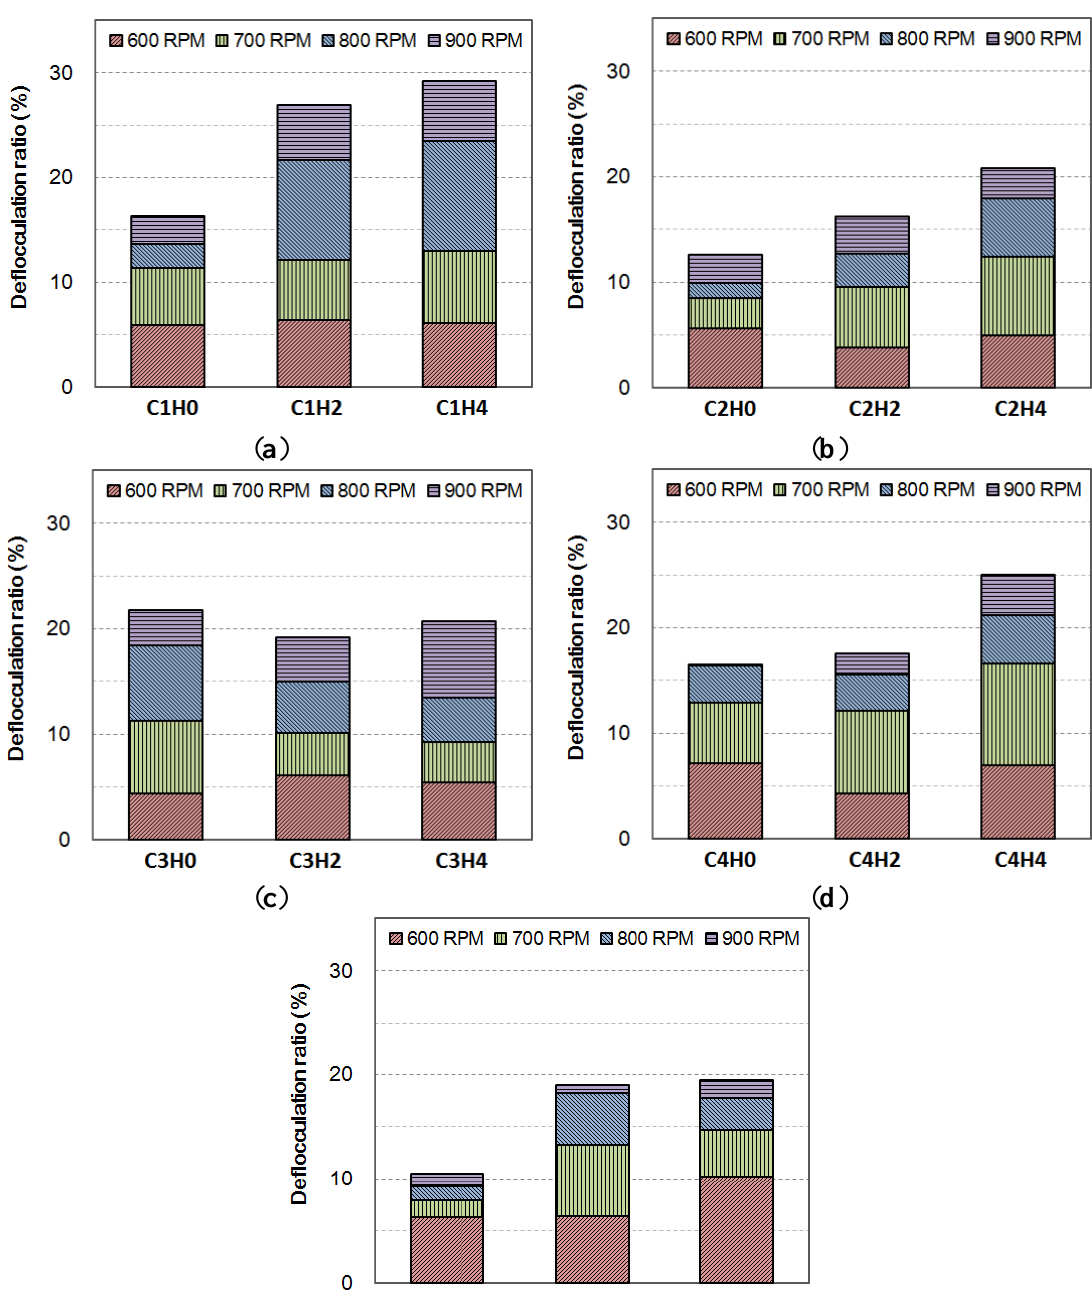
Figure 7. Deflocculation ratio of the cement pastes: ( a ) C1; ( b ) C2; ( c ) C3; ( d ) C4;